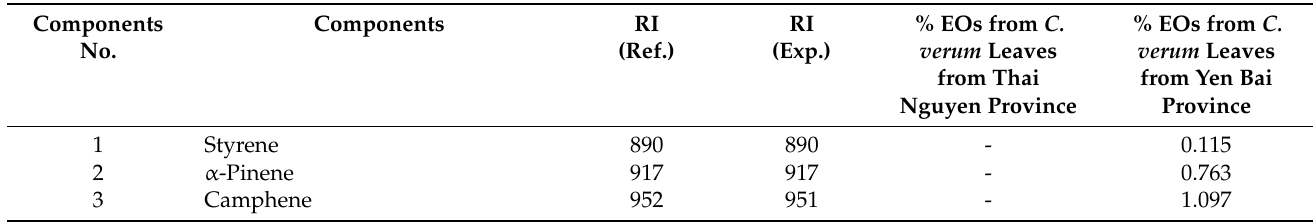
Table 2. Chemical components of C. verum leaf EOs from different cultivation